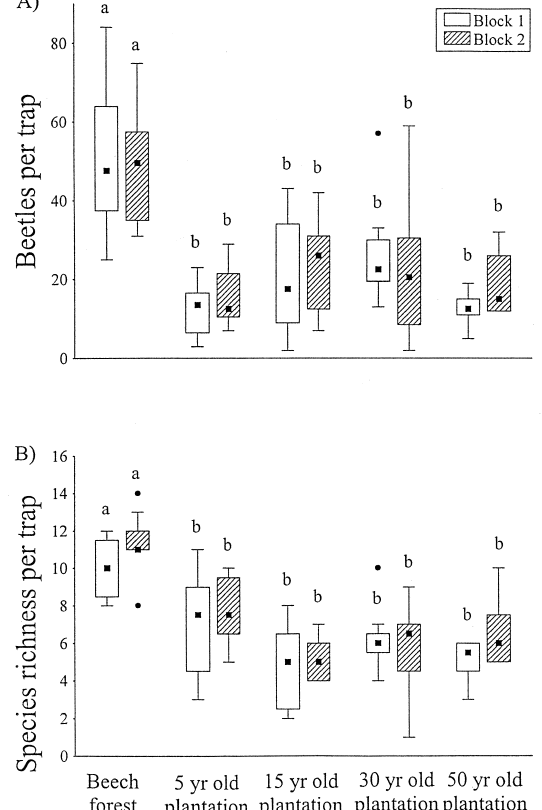
Fig. 1. Box and whisker plots of the number of carabid individu- als A) and species richness B) per trap in the studied forests for the two repeated trapping stations (Block 1 and 2). Boxes represent the 25 and 75 percentiles of the data, while whiskers contain the non-outlier data; outlier data items are indicated by dots. Differ- ent letters indicate a significant (p<0.05) difference in the medi- ans by Tukey-type multiple comparison. Legends: (cid:1) : median, • :